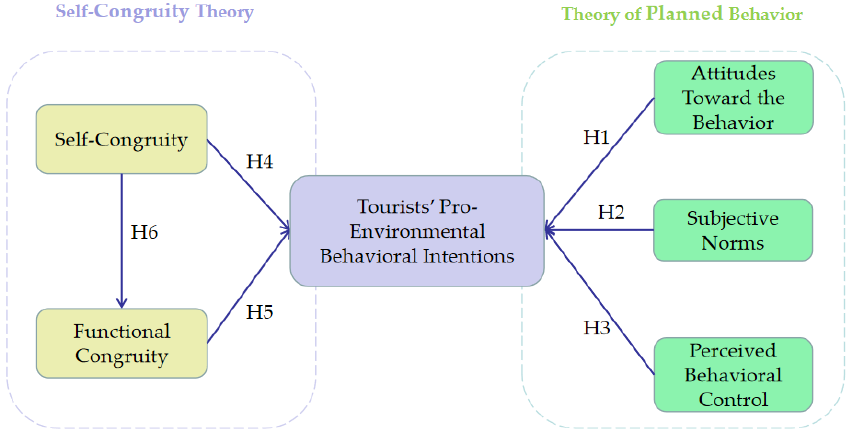
Figure 1. The integrated theoretical framework of this research .